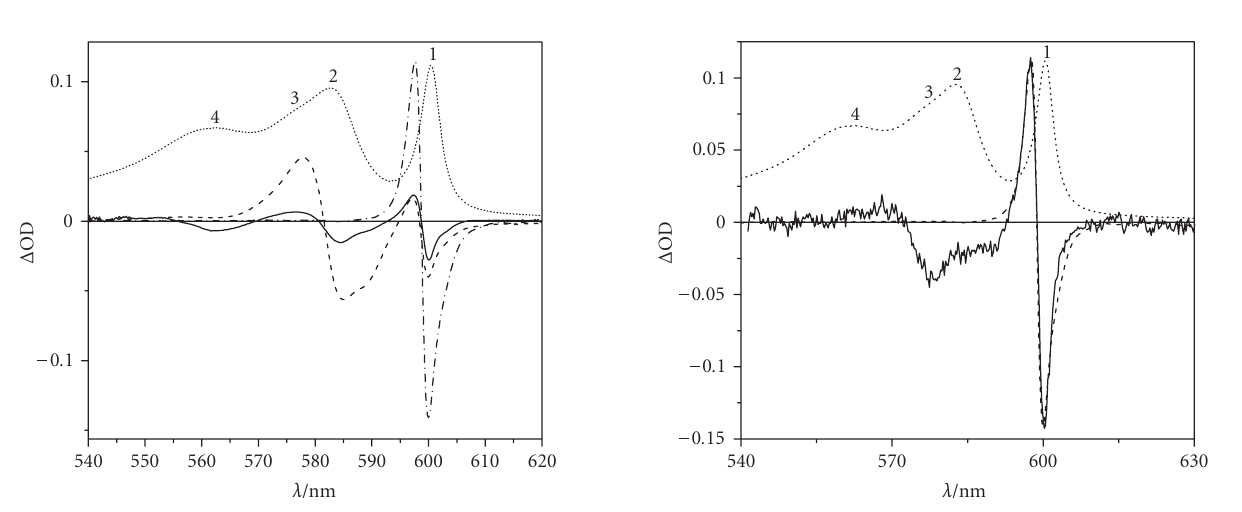
Figure 3: Zero-delay pump-probe spectra of pure C8O3 aggre- gates at excitation wavelengths 600 nm (dash-dotted line), 580 nm (dashed line), and 560 nm (solid line). Polarization of the probe beam is parallel to the flow. The dotted line represents the isotropic linear absorption spectrum.